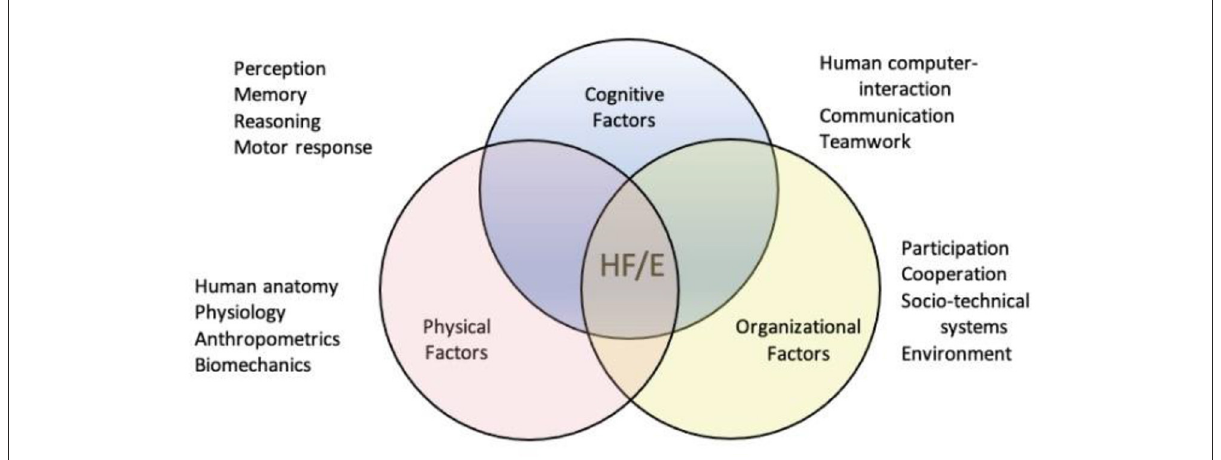
FIGURE1 Interdisciplinary identity of ergonomics and the three main classic areas of research (7).